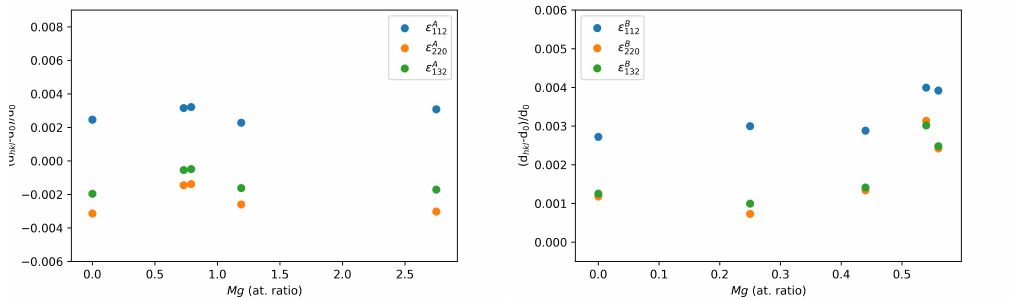
Figure 3. Normalized deviation from the corresponding peak position of the Cu 2 ZnSnS 4 (CZTS) structure for selected reflections in terms of the samples’ Mg content. KA series ( left ) and KB series ( right ).